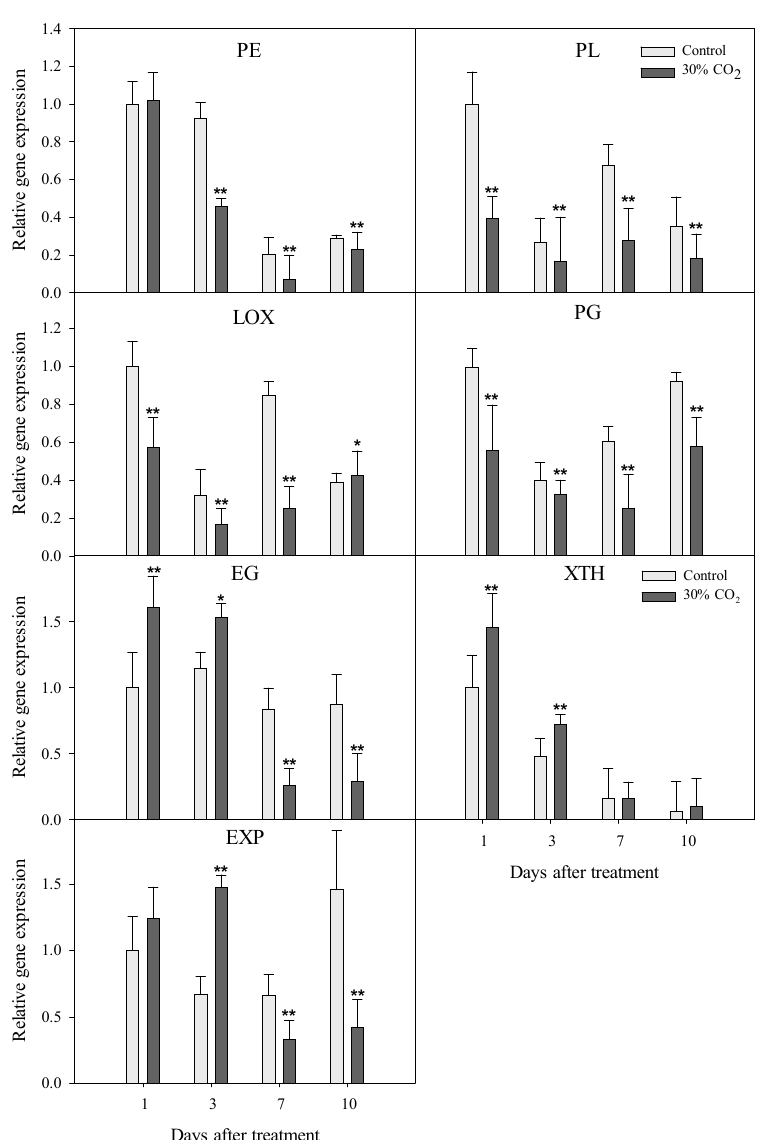
Figure 2. Expression levels of genes encoding cell wall-degradation enzymes in strawberry fruits treated with 30% CO 2 for 3 h, as well as control fruits. PE, pectinmethylesterase; PL, pectate lyase; LOX, lipoxygenase; PG, polygalacturonase; EG, endo- β -1,4-glucanase; XTH, xyloglucan endo- transglucosylase/hydrolase; EXP, expansin. * p < 0.05; ** p < 0.01.